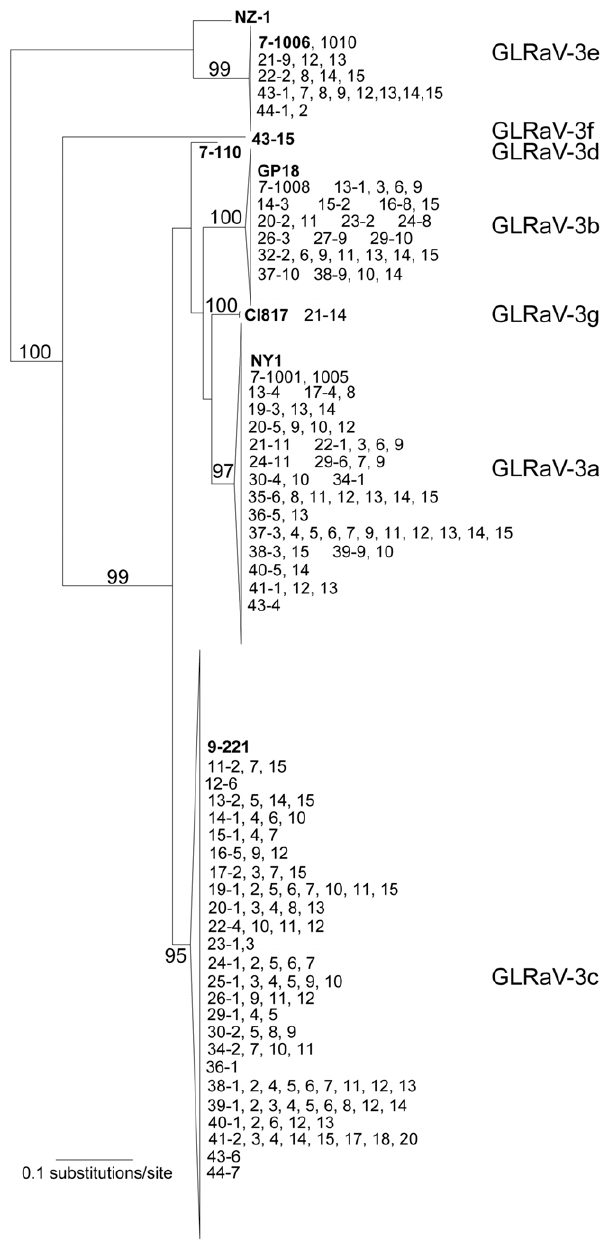
distributed across the region to run the analysis, -3d was limited to one block and -3e was found in two pairs of neighboring blocks (21/22 and 43/44).